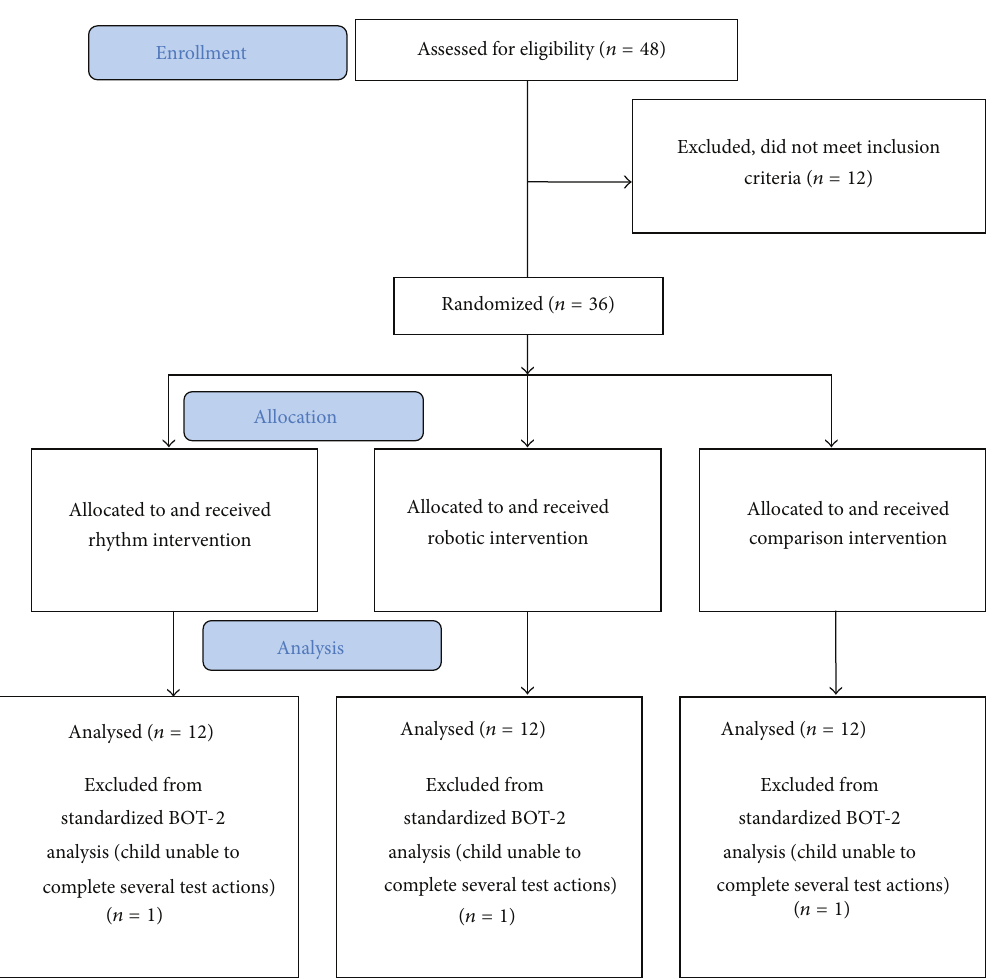
Figure 1: CONSORT flow